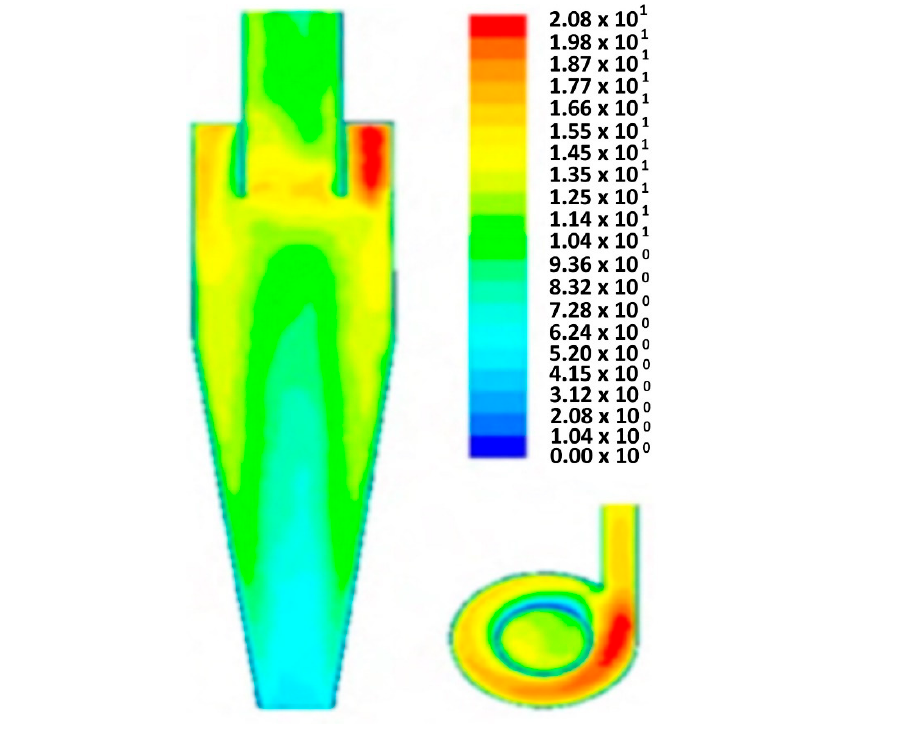
Figure 7. Velocity magnitudes [19].